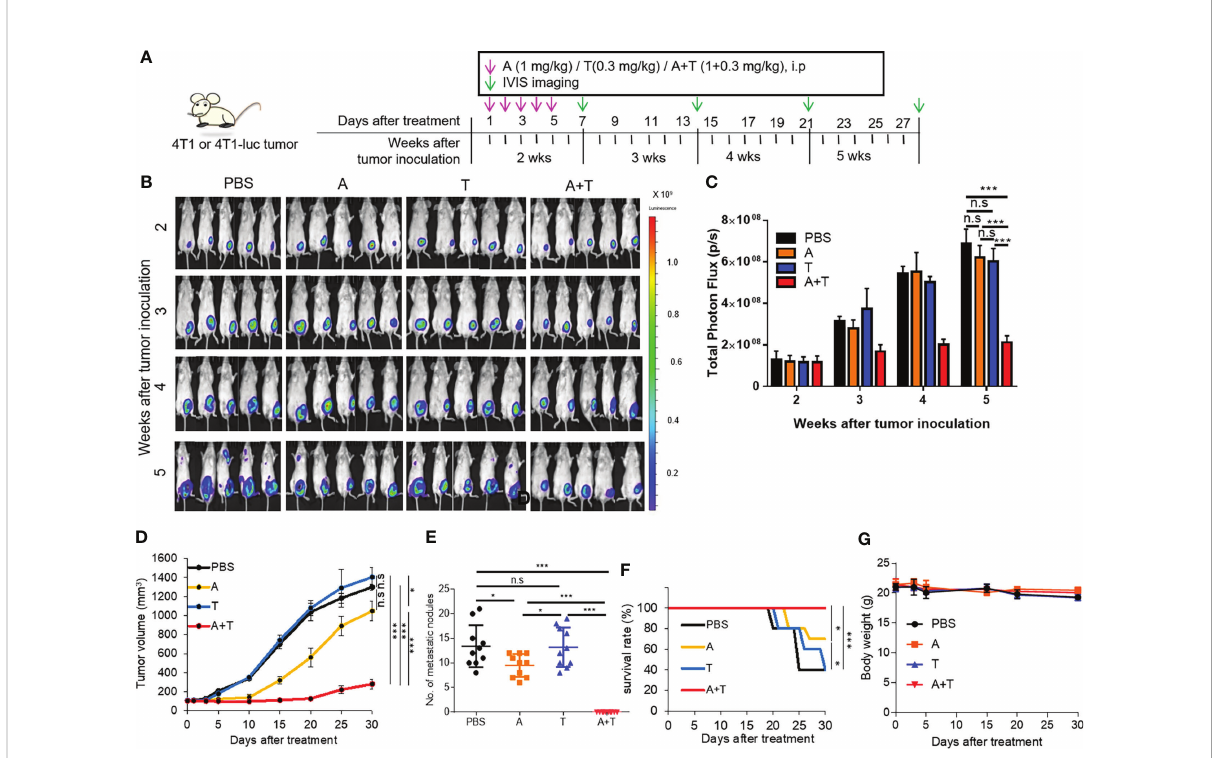
FIGURE 3 Epigenetic therapy with 5-aza-dC and TSA synergistically inhibits breast tumor growth in mice. (A) Experimental schemes of the tumor therapy. Mice bearing 4T1 or 4T1-luc tumors (approximately 100 – 150 mm 3 in size) in the left and lower mammary gland were treated with 5-aza-dC and TSA, alone or in combination (1 mg/kg body weight 5-aza-dC and 0.3 mg/kg body weight TSA, once a day, for 5 d), at 2 weeks after tumor inoculation. (B) Whole-body bioluminescence images of mice bearing 4T1-luc tumors were taken 10 min after injection of D-luciferin into the mice after treatments. Scale bar represents the intensity of luminescence. (C) Quantitation of the total photon fl ux (the number of photons per second, p/s) obtained upon whole-body imaging. Data have been presented as the mean ± S.D. ***, P <0.001; n.s., not signi fi cant ( n =5 per group), as assessed using two-way ANOVA. (D – G) Tumor volumes (D) , body weight (E) , number of metastatic nodules in the lung (F) , and survival rates (G) after treatments. Data have been presented as the mean ± S.D. *, P <0.05; ***, P <0.001; n.s., not signi fi cant ( n =10 mice per group), as assessed using one-way ANOVA followed by Tukey ’ s multiple comparison post-hoc